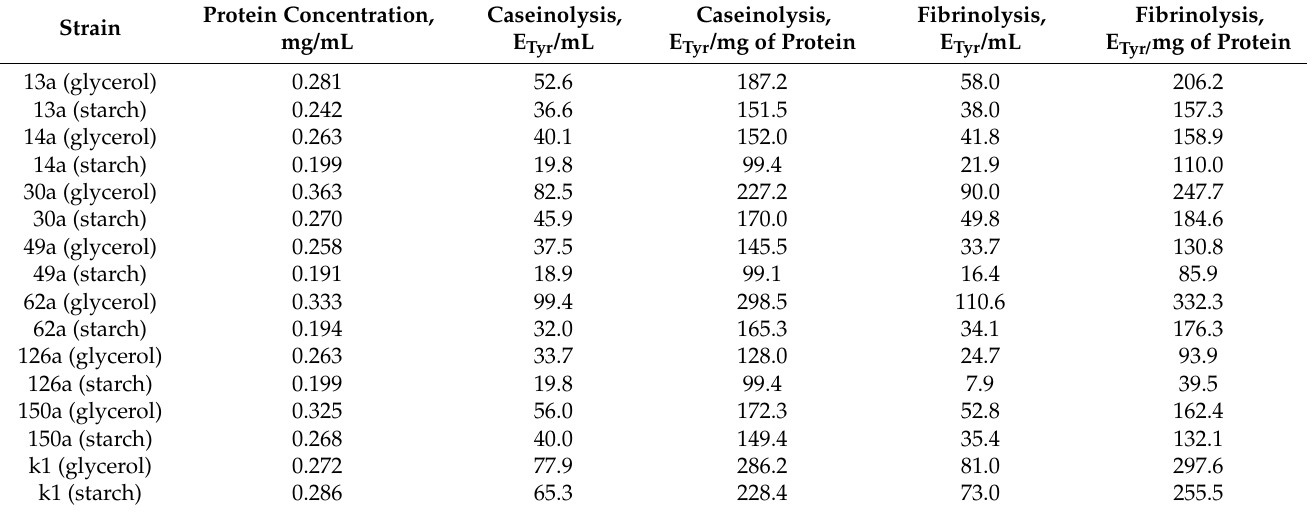
Table 3. Determination of caseinolytic and fibrinolytic activity of Tolypocladium -strain preparations obtained from submerged cultivation in media with glycerin and